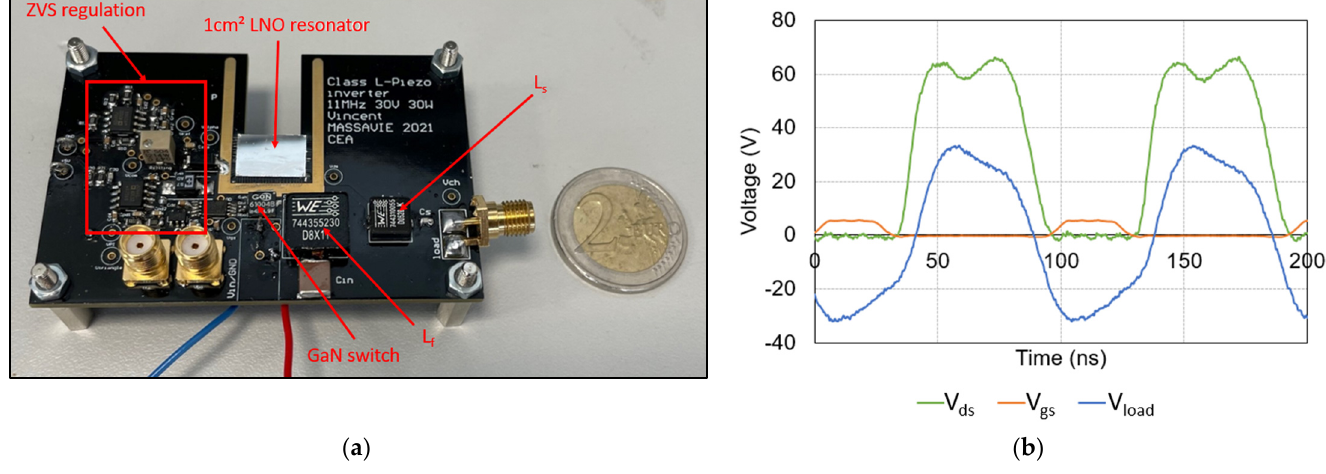
Figure 9. Prototype with piezoelectric filter ( a ), and characteristic voltages of the L − Piezo inverter ( b ).